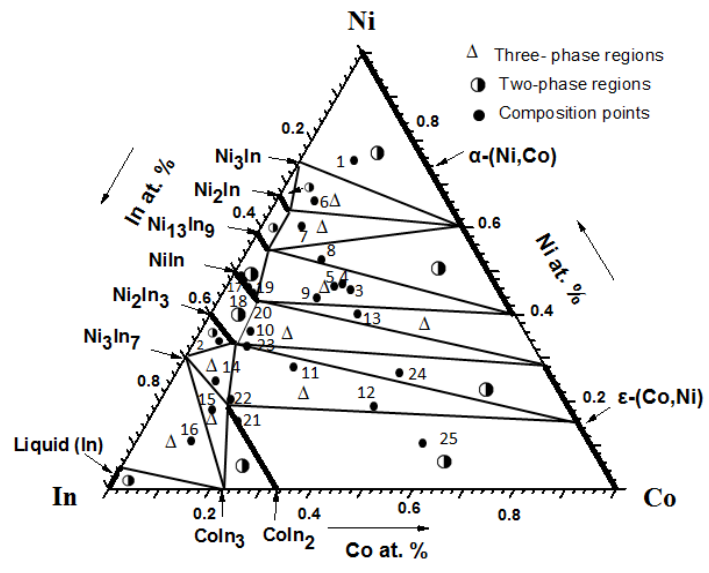
Figure 13. Isothermal section of the Co-Ni-In system at 673 K. Table 2. Typical samples and details of three-phase regions in the Co-Ni-In ternary system at 673 K. Phase